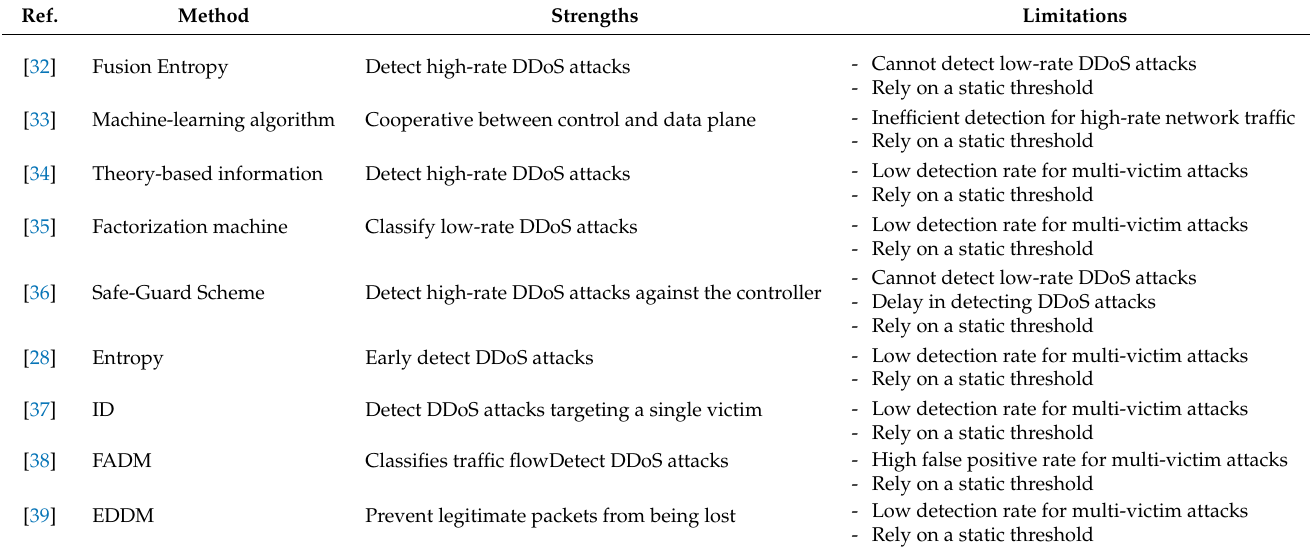
Table 1. Summary of DDoS attack on SDN controller detection